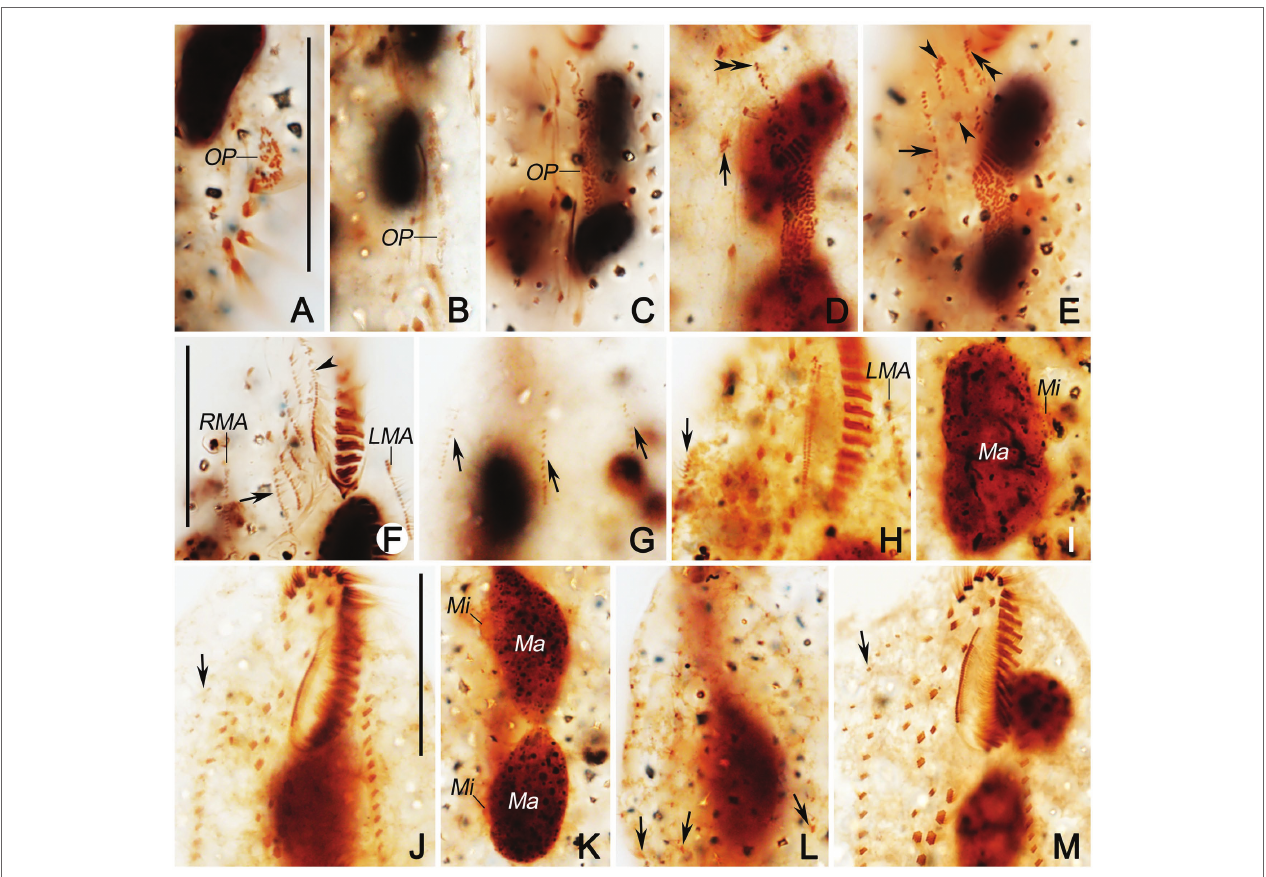
FIGURE 5 | Photomicrographs of Quadristicha subtropica n. sp. during morphogenesis, after protargol staining. (A–C) Early morphogenetical stages in ventral views, showing the newly formed oral primordium. (D) Ventral view of early divider, arrow marks the dedifferentiation of cirrus V/4, and double arrowheads indicate the UM-anlage. (E) Ventral view of early divider, arrow shows the frontal-ventral-transverse cirral anlagen, arrowheads mark the dedifferentiation of cirri IV/2 and IV/3, and double arrowheads indicate the UM-anlage. (F,G) Ventral and dorsal view of a divider, arrow in (F) shows frontal-ventral-transverse cirral anlagen, arrowhead marks undulating membranelles anlage, and arrows in (G) show dorsal kineties anlagen. (H) Ventral view of a mid-divider, arrow marks the dorsomarginal kineties anlage. (I) Dorsal view, to denote the fusion of the macronuclear nodules. (J,M) Ventral views, to show the ciliature. Arrows mark the dorsomarginal kinety anlagen. (K) Dorsal views, to demonstrate the development of the macronuclear nodules. (L) Dorsal view, arrows point to the caudal cirri. Bars: 30 μ m.